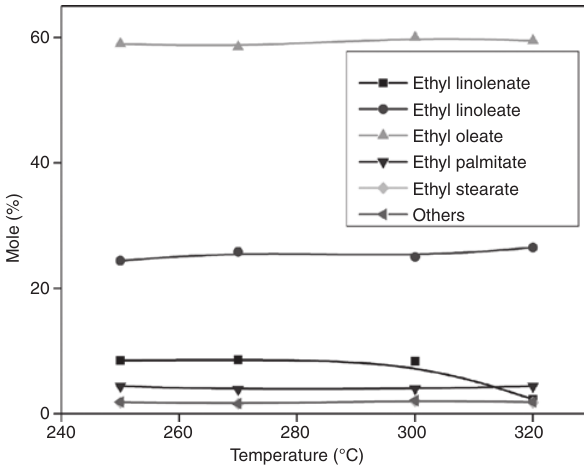
Figure 13: Effect of temperature on fatty acid ethyl ester composi- tion at reaction conditions: 60 min, 3% wt ZnO, molar ratio